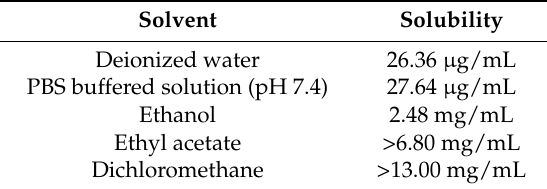
Table 1. The solubility of TP 5 in various solvents (n = 3).